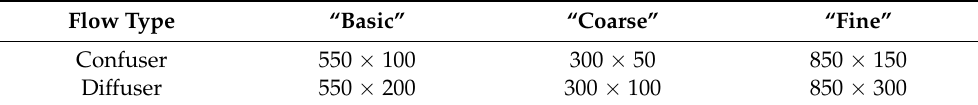
Table 1. Meshes for two-phase flow in the confuser (FPG) and diffuser (APG). Flow Type